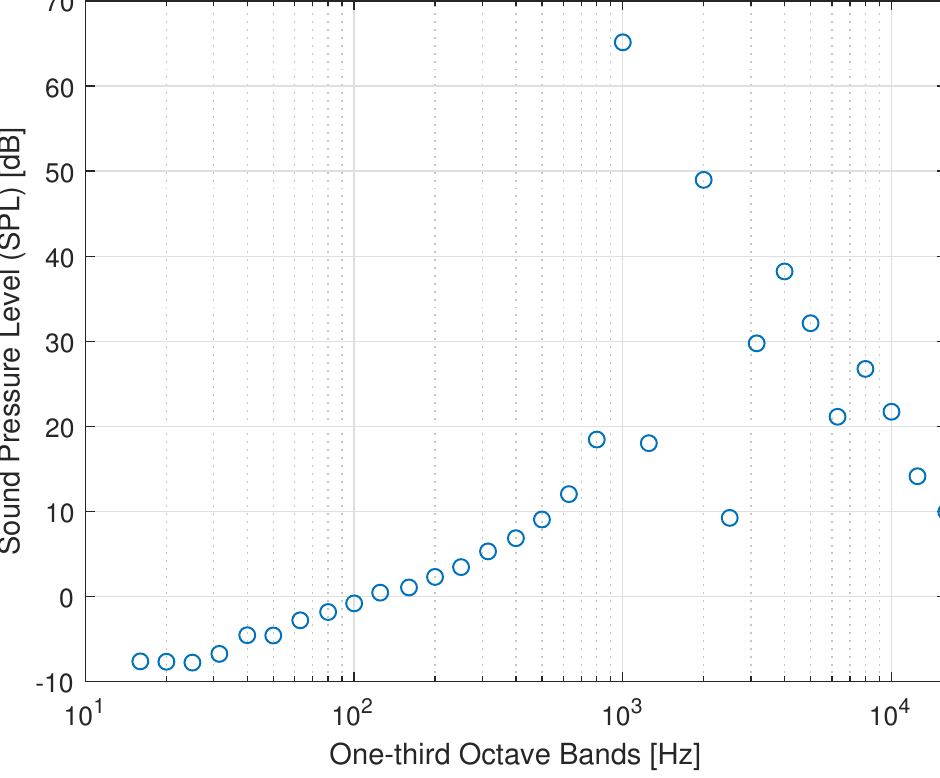
Figure 17. NLR7301 thickness noise one-third octave bands at azimuthal position of 90 ◦